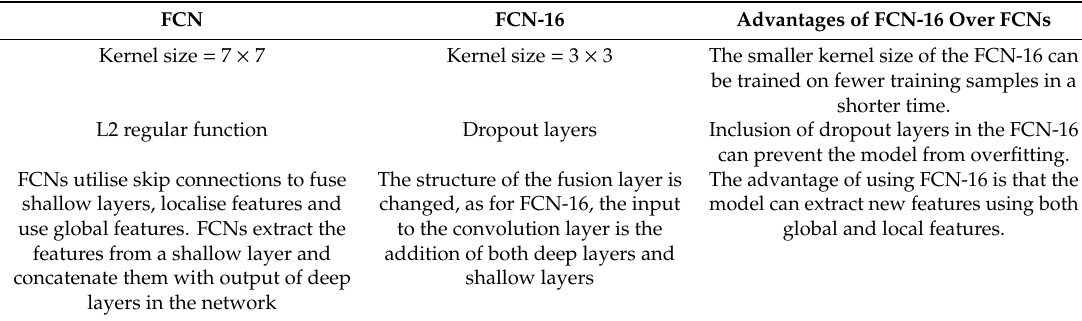
Table 5. Comparison between fully convolutional networks (FCNs) and the proposed algorithm FCN-16 [93].